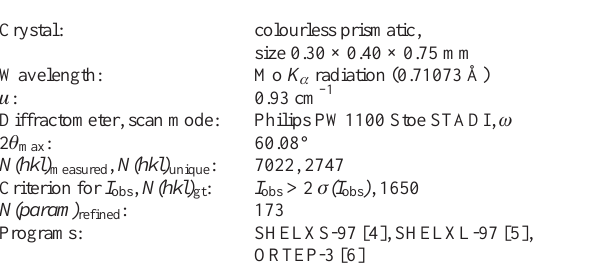
Table 1. Data collection and handling.